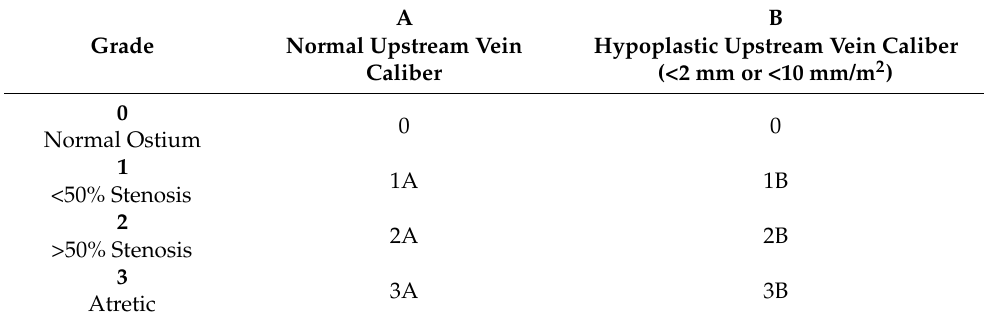
Table 1. PVS Grading System.